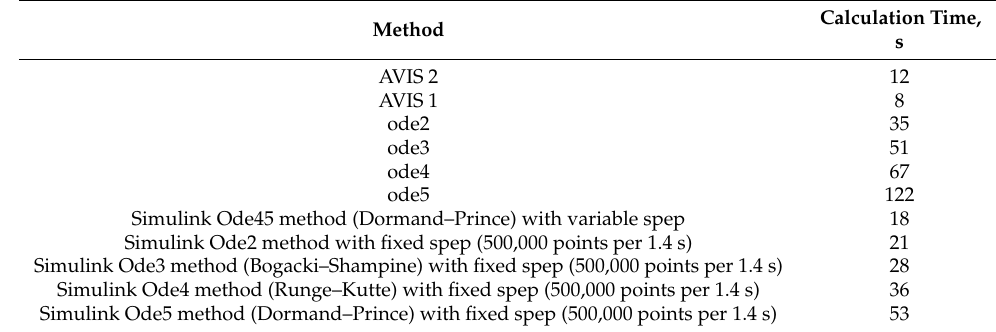
Table 1. Speed of response for calculation time of 1.4 s corresponding to 500,000